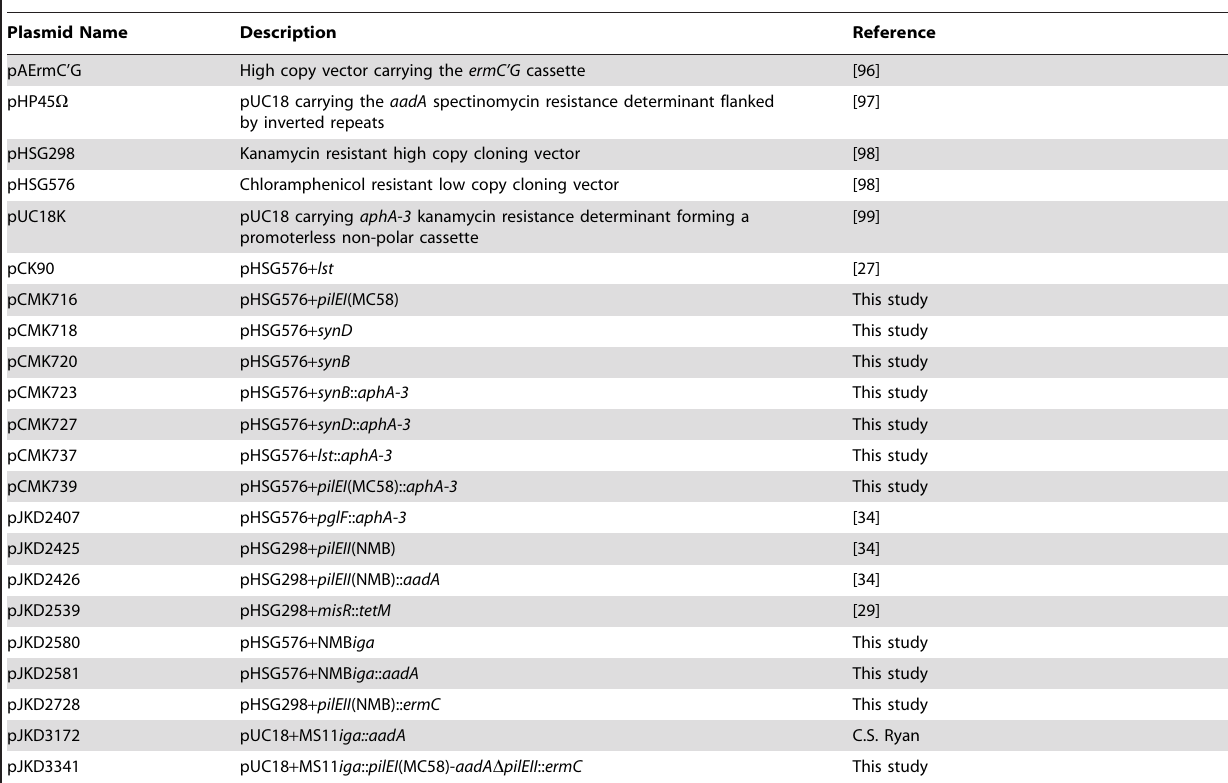
Table 2. Plasmids used in this study.